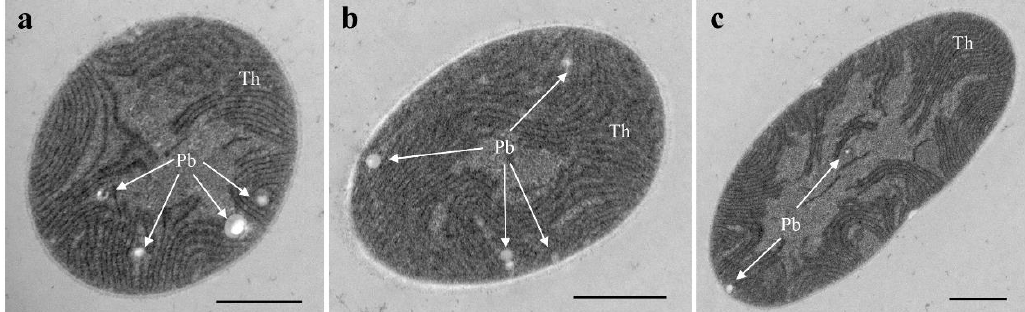
Figure 2. TEM micrographs of Cyanodorina ovale. ( a ) Cross section of a cell. ( b ) Longitudinal section of a cell. ( c ) Dividision of a cell. Pb, polyphosphate body, Th, thylakoids. Scale bars: 1 µm.